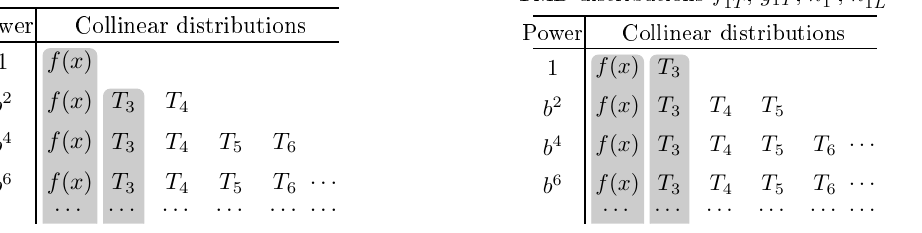
Figure 1 . Ordering of parton distributions in the small- b series for TMD distributions (1.3) (left) and (1.4) (right). f ( x ) denotes the ordinary PDFs. T n denotes the parton distribution of twist-n, which is generally a function of several variables. The gray boxes designate the terms computed in this